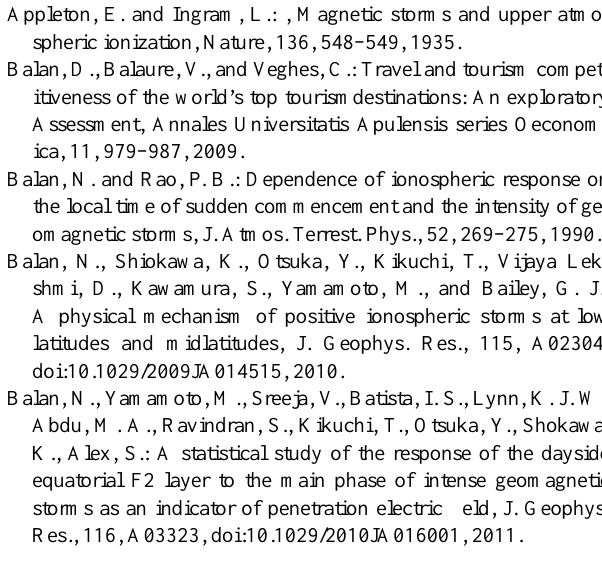
Figure 10 The descending orbit of the Jason-1 satellite and the VTEC observations on the study region on May 15.